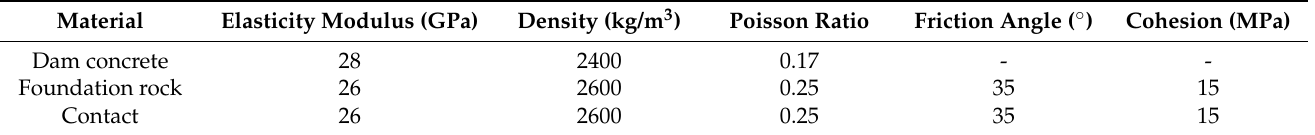
Table 2. Main material properties. Calculation